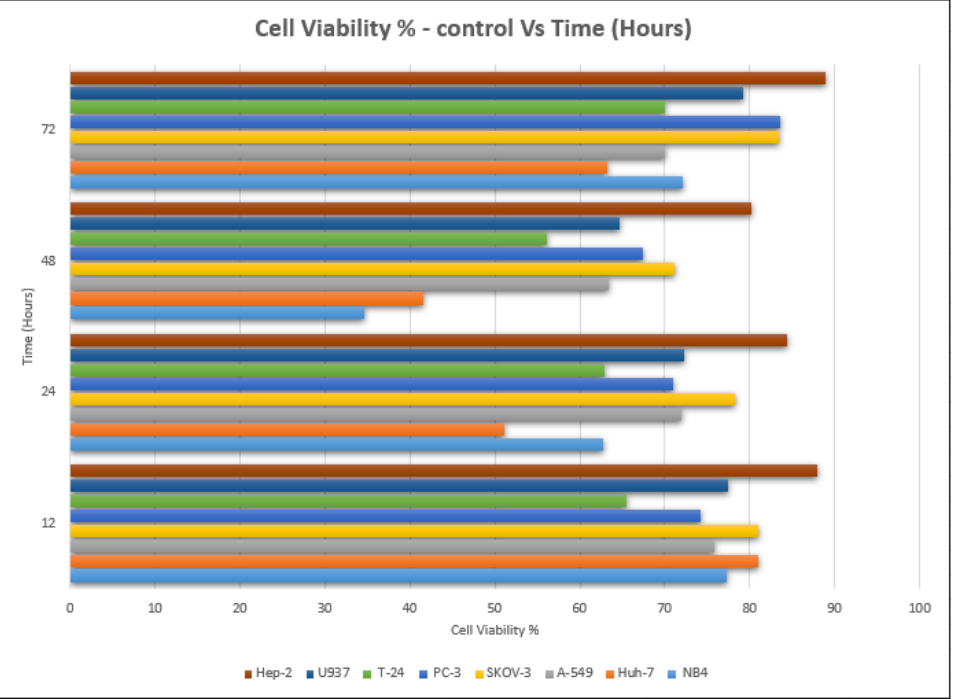
Figure 4. Cell viability % with time (h) of P. amygdalus var . amara for 8 cancer cell lines. Morphological changes in Huh-7 (hepatocellular carcinoma) were studied after being treated with P. amygdalus . The morphological alterations observed in Huh-7 cells are shown in Table 2. Changes in morphology were found to be concentration-dependent.